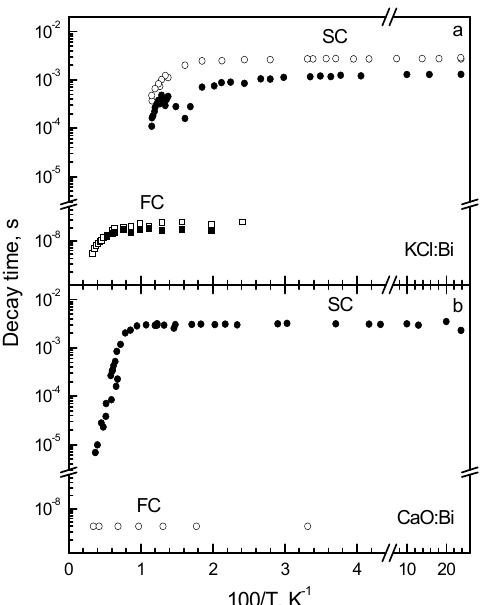
Figure 9. Temperature dependences of the decay times of the slow (SC) and fast (FC) decay components of the triplet luminescence of ( a ) KCl:Bi and ( b ) CaO:Bi. In ( a ), E exc = 3.7 eV, E em = 2.68 eV (empty circles) and 2.84 eV (solid circles), E em = 2.46 eV (empty squares) and 2.54 eV (solid squares). In ( b ), E exc = 3.6 eV, E em = 3.1 eV (solid circles) and E em = 3.3 eV (empty circles). Based on the data reported in [85]. Presented with the publisher’s permission.